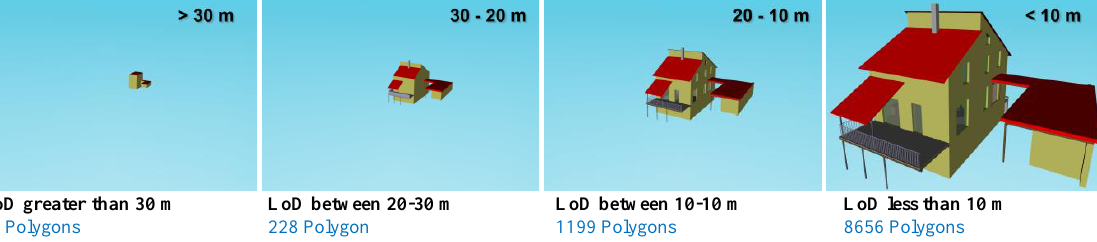
Figure 1: LoD switches in VRML / X3D (source